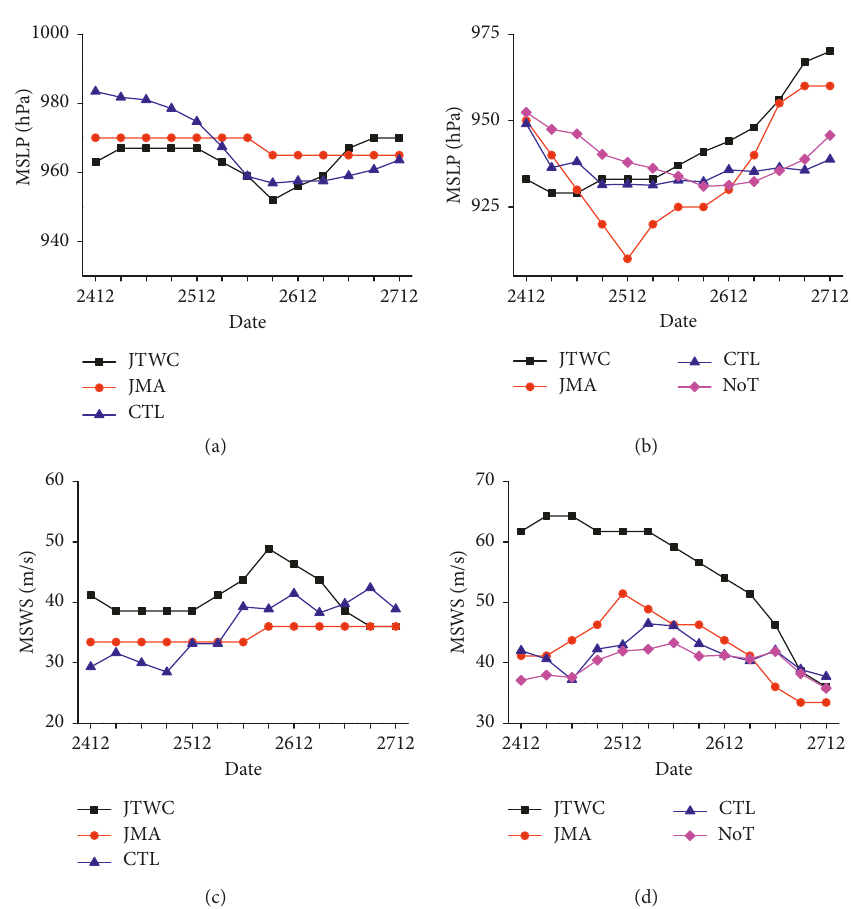
1 ) of Tembin (a, c) and Bolaven (b, d) from 1200 UTC 24 August to −